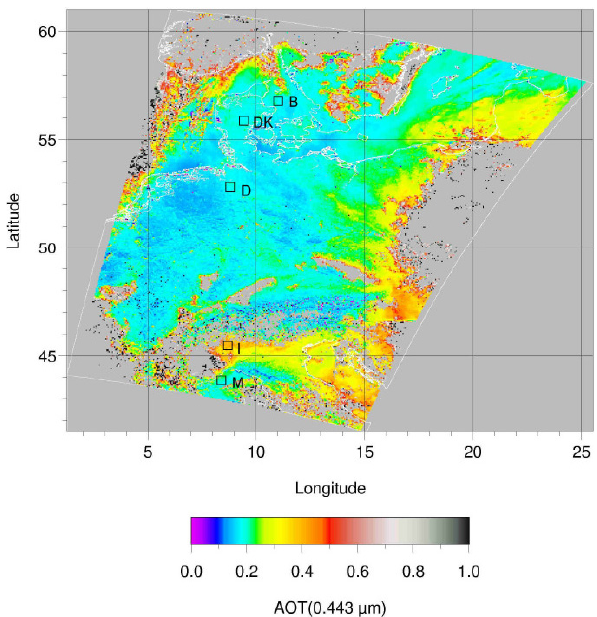
Fig. 15. Retrieval of AOT at 0.443µm over Germany and sur- rounding areas, using MERIS RR L1 data of 13 October 2005, 09:54UTC, showing average autumnal aerosol loading. Pollution in the valley of the river Po in northern Italy is visible. Increased AOT also is seen in the vicinity of the large cloud system at the east side of the swath, probably caused by cloud